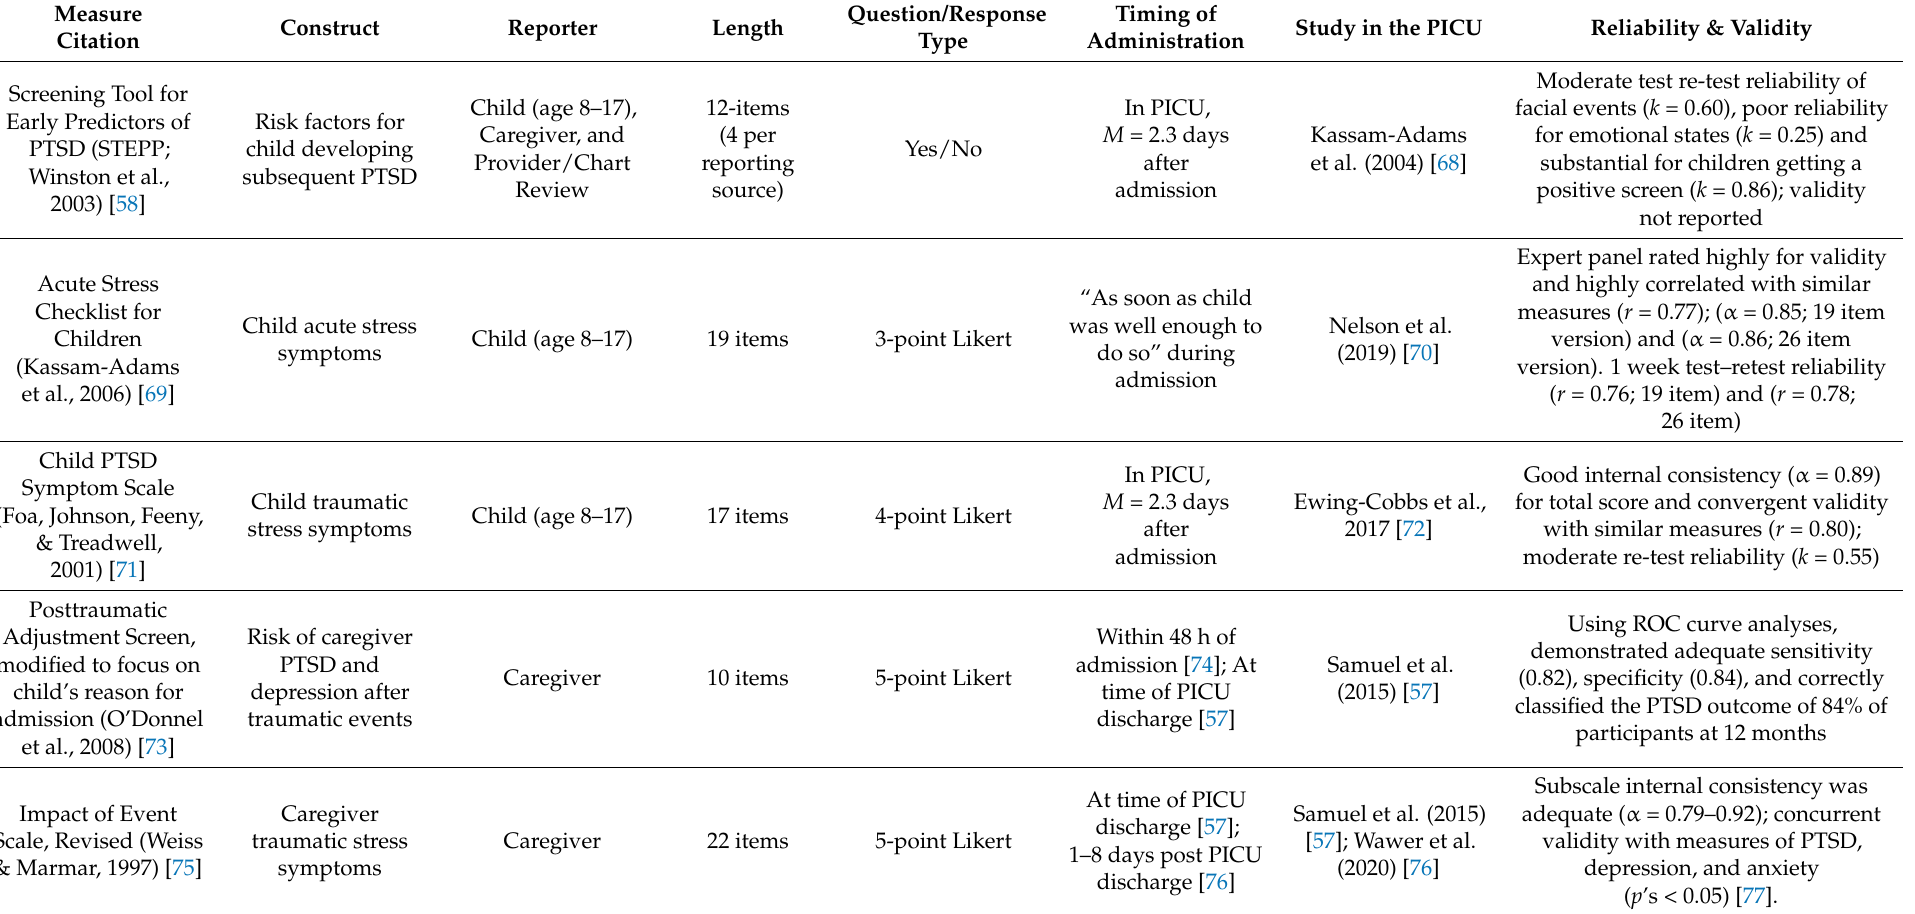
Table 1. Screening Tools Studied with Children and Caregivers in